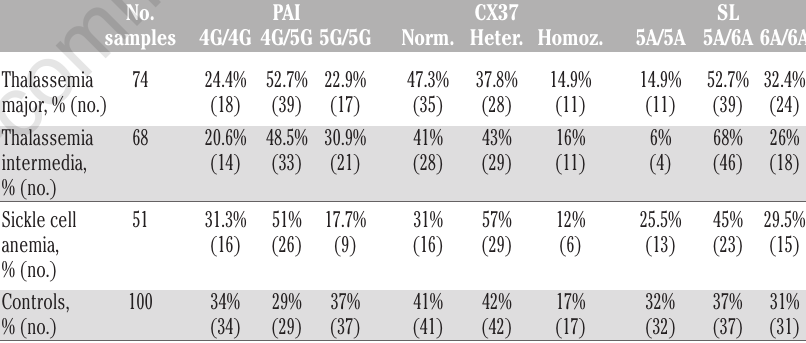
Table 2. Results of molecular analysis of the PAI, CX37 and SL genes.